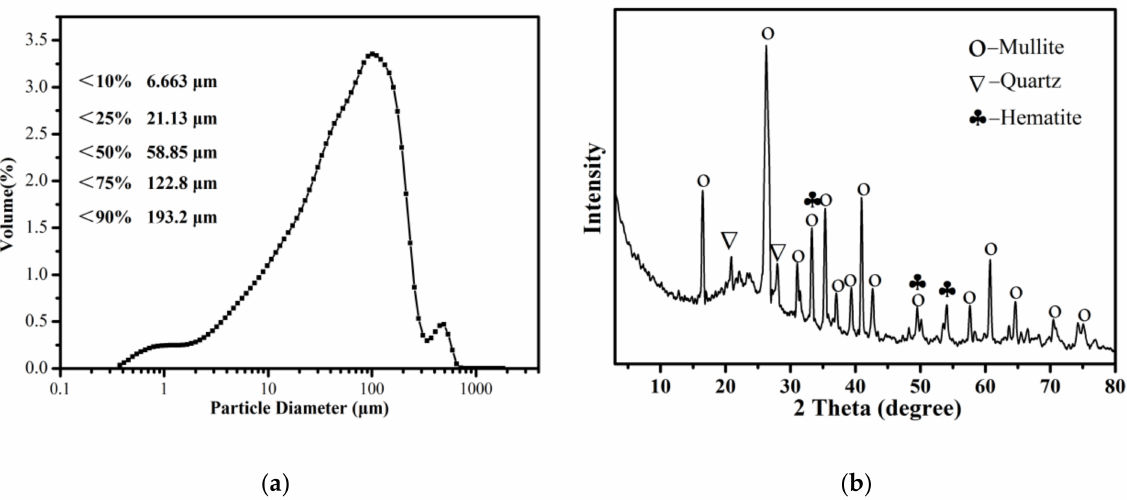
Figure 1. ( a ) The particle size distributions of the raw CFA powder.( b ) The XRD pattern of the raw CFA